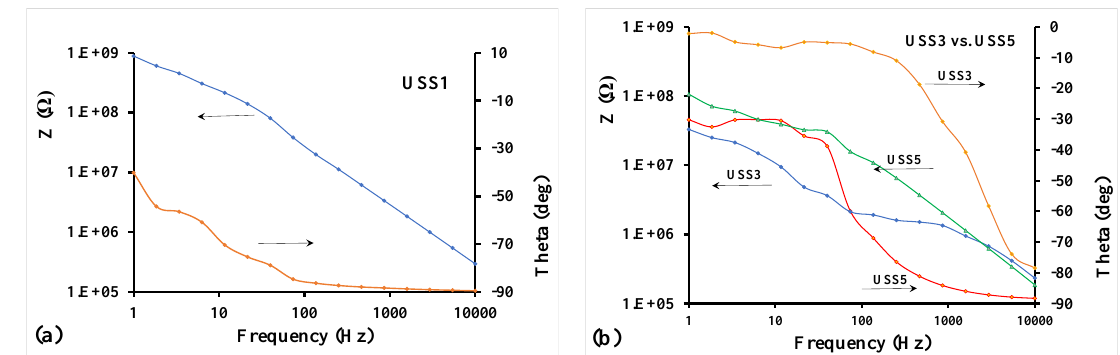
Figure 12. ( a ) Impedance spectrum of membrane sample USS1; ( b ) Effect of higher concentration of MWCNTs and of cycle duty (30 and 100%), on the impedance spectra of samples USS3 and USS5.